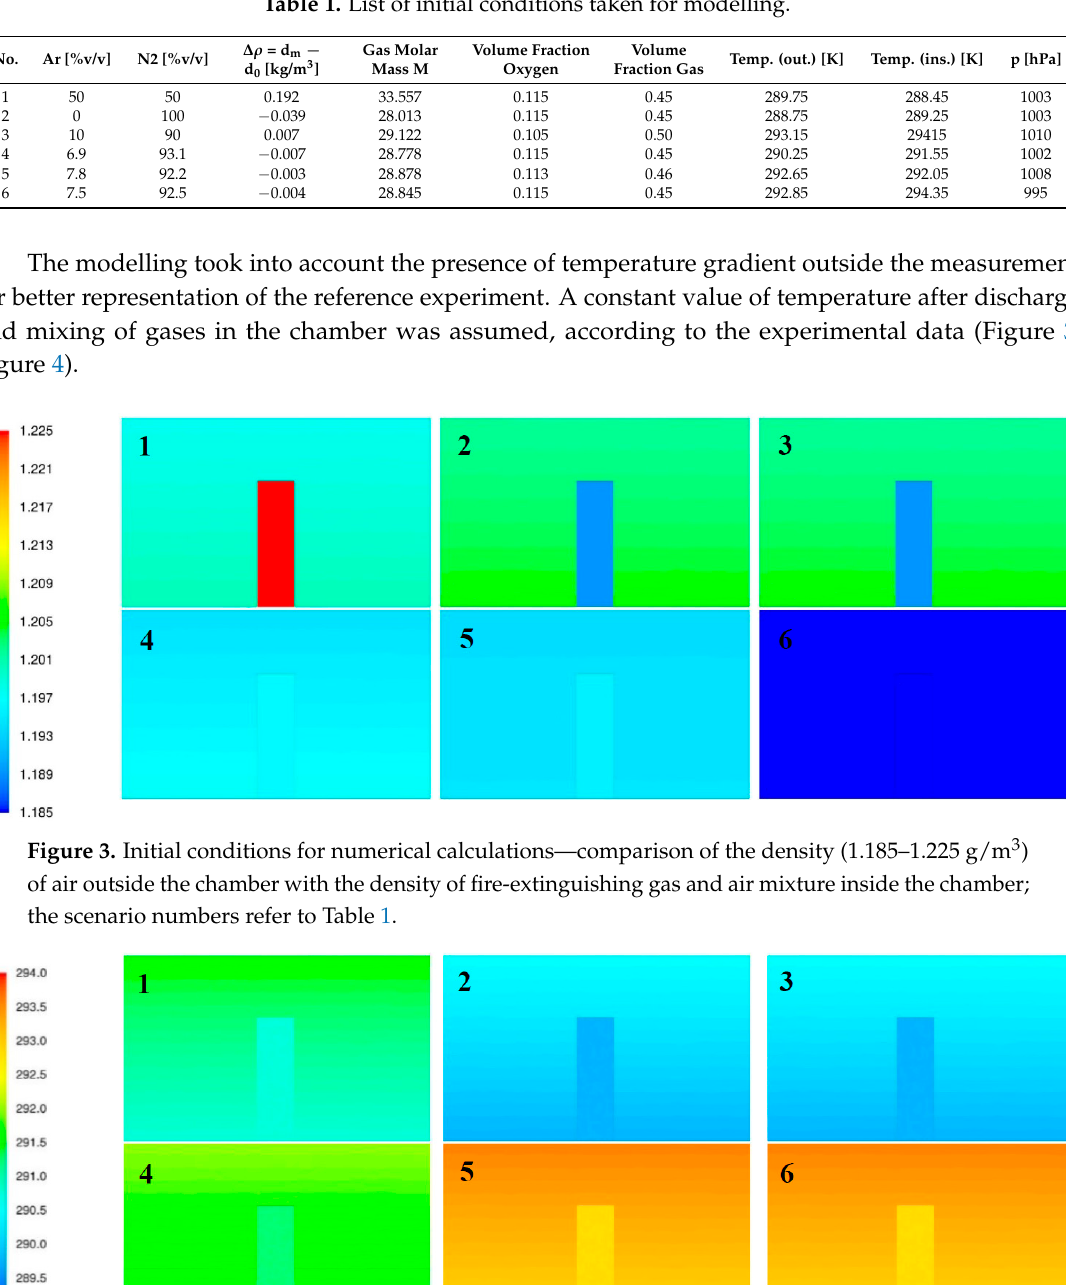
Table 1. List of initial conditions taken for modelling.